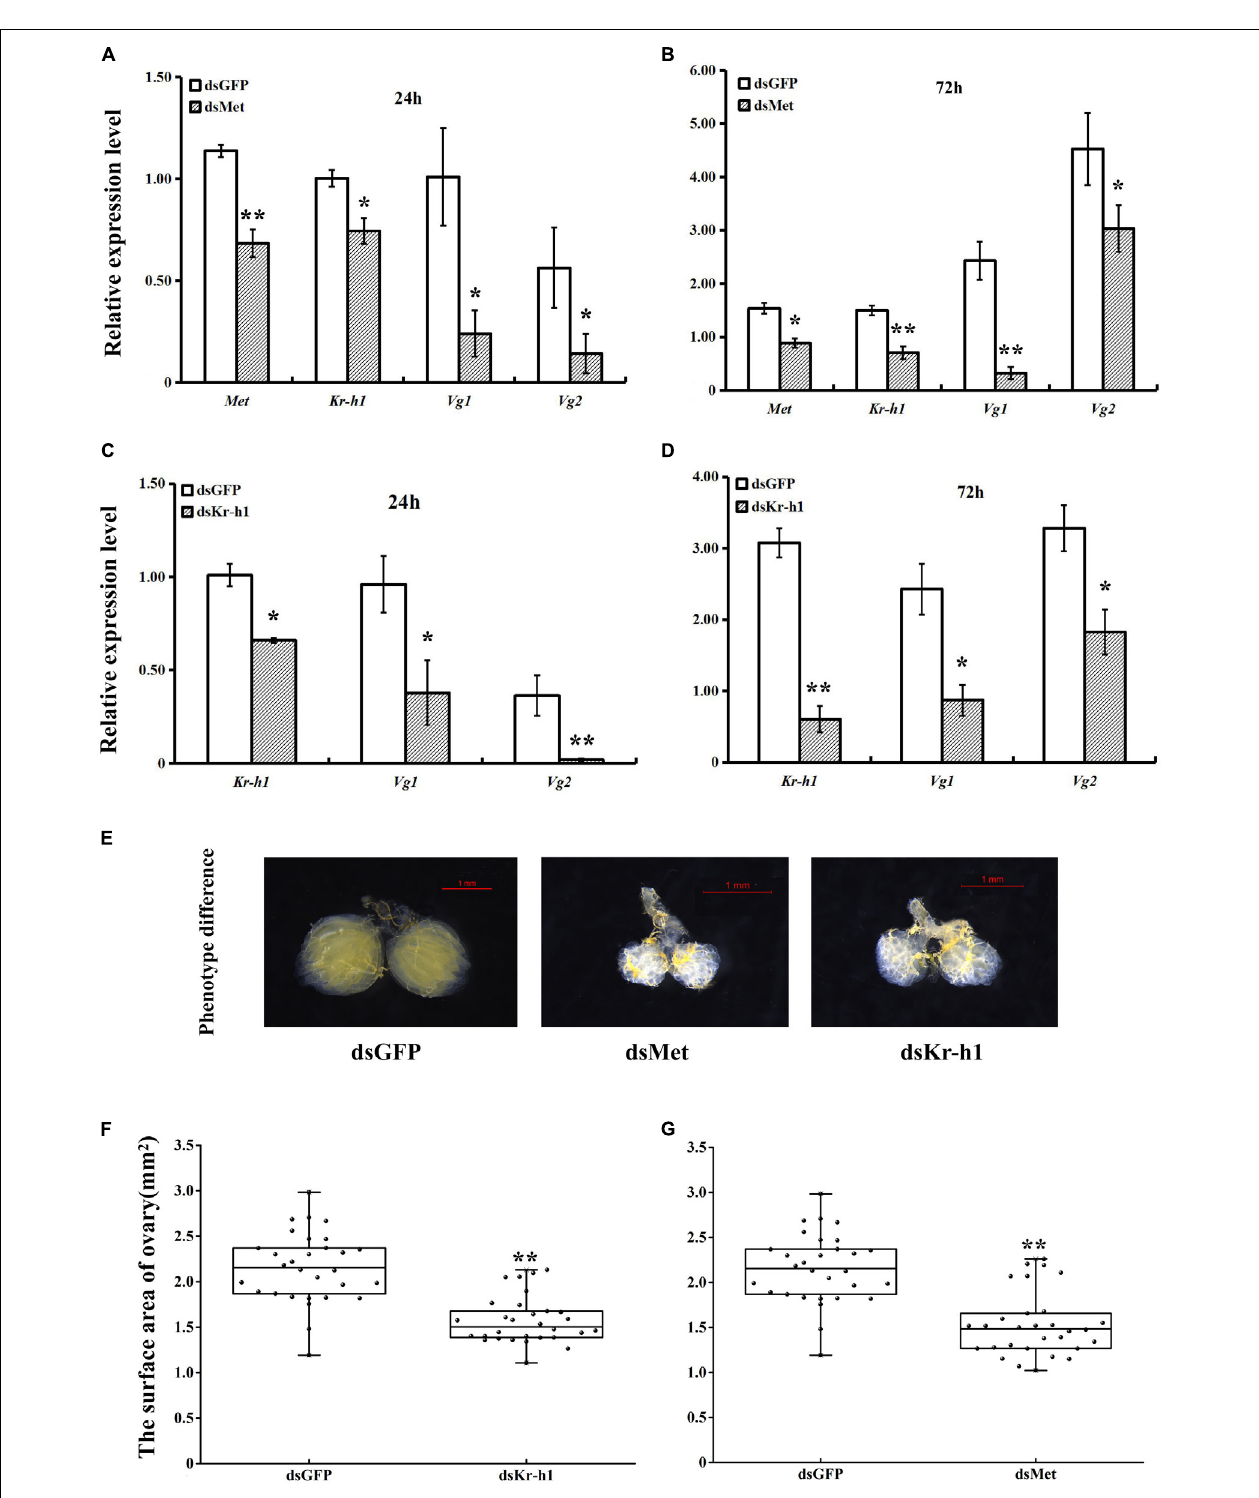
FIGURE 4 | Effects of BdMet or BdKr-h1 silencing on expression levels of JH signaling and Vg genes and corresponding ovary observation. Transcript levels of BdMet , BdKr-h1 , BdVg1 , and BdVg2 24 h (A) and 72 h (B) after dsMet injection. Transcript levels of BdKr-h1 , BdVg1 , and BdVg2 24 h (C) and 72 h (D) after dsKr-h1 injection. Three replicates were conducted, and the data were presented as mean ± SE. (E) Effects of Met and Kr-h1 RNAi on ovary development with dsGFP as a control. The surface area of ovary recorded after Kr-h1 RNAi (F) and Met RNAi (G) . Every dot means the surface area of individual ovary. The asterisks indicate statistically significant difference between measurements ( ∗ P < 0.05, ∗∗ P < 0.01).